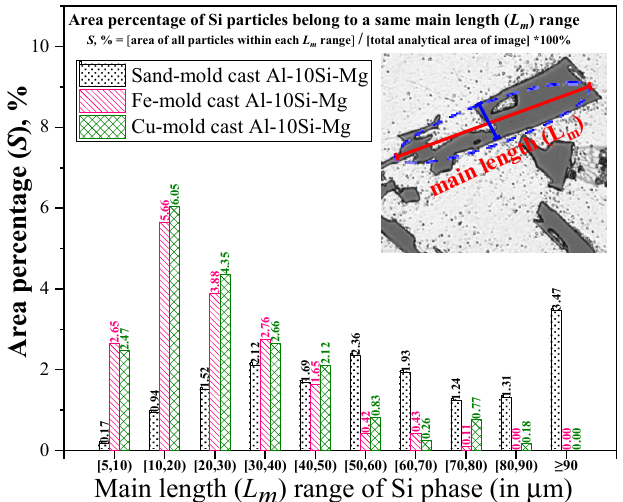
Figure 9. Area percentage (S, %) of Si particles within each main length ( L m ) range in the sand/Fe/Cu- mold cast Al-10Si-0.5Mg alloys. Excluding SLM alloy due to the continuous network distribution of Si phase that is difficult to count for each size range.